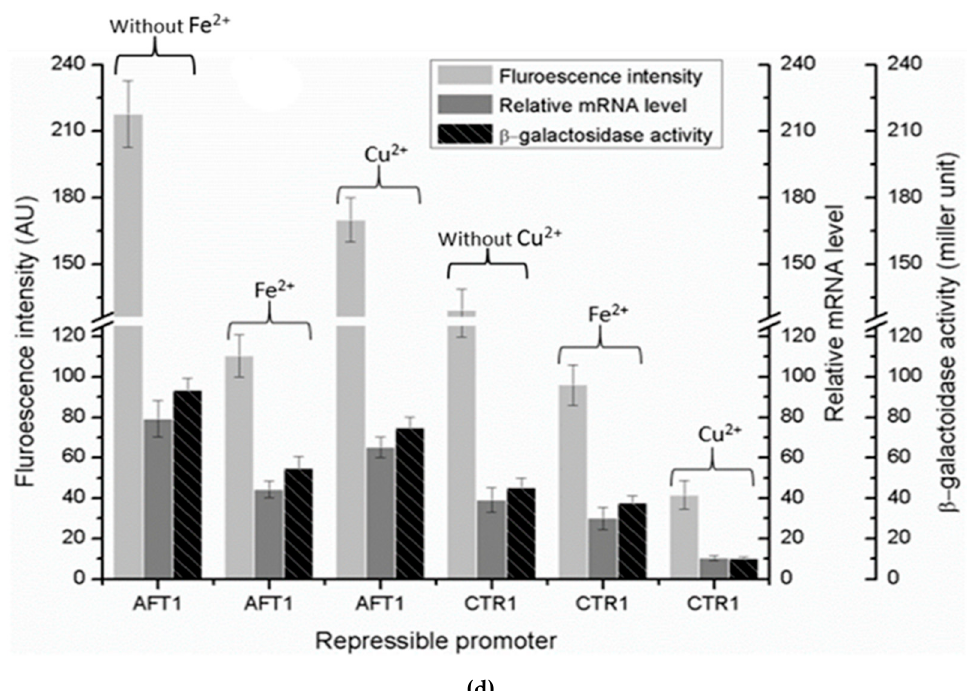
Figure 2. Tuning of the strength of yeast constitutive promoters: ( a ) Strategy for tuning the strength of yeast constitutive promoters transcription factor binding sites (TFBS) from strong constitutive promoters TEF1p ( − 300 to − 579bp) and HHF2p (-300 to -669bp). ( b ) Characterization of the strength of engineered promoters constructed by ligating the TFBS - TEF1p upstream of HHF2p, IRA1p, RHO1p, PET9p, CMD1p, ATP16p, USA3p, RER2p, COQ1p, RIM1p, GRS1p, MAK5p, and BRN1p using reporter genes EGFP and LacZ . ( c ) Characterization of the strength of engineered promoters constructed by ligating the TFBS - HHF2p upstream of HHF2p, IRA1p, RHO1p, PET9p, CMD1p, ATP16p, USA3p, RER2p, COQ1p, RIM1p, GRS1p, MAK5p, and BRN1p using reporter genes EGFP and LacZ . Error bars represent the standard deviation of biological triplicate. ( d ) Characterization of the strength of metal ion repressible promoters. The strength of AFT1p and CTR1p was characterized using reporter genes EGFP and LacZ . Metals ion, Fe 2 + , and Cu 2 + , were tested to repress the strength of AFT1p and CTR1p promoters. Both metals ion repressed the strength of AFT1p and CTR1p to a di ff erent level. Error bars represent the standard deviation of biological triplicate.